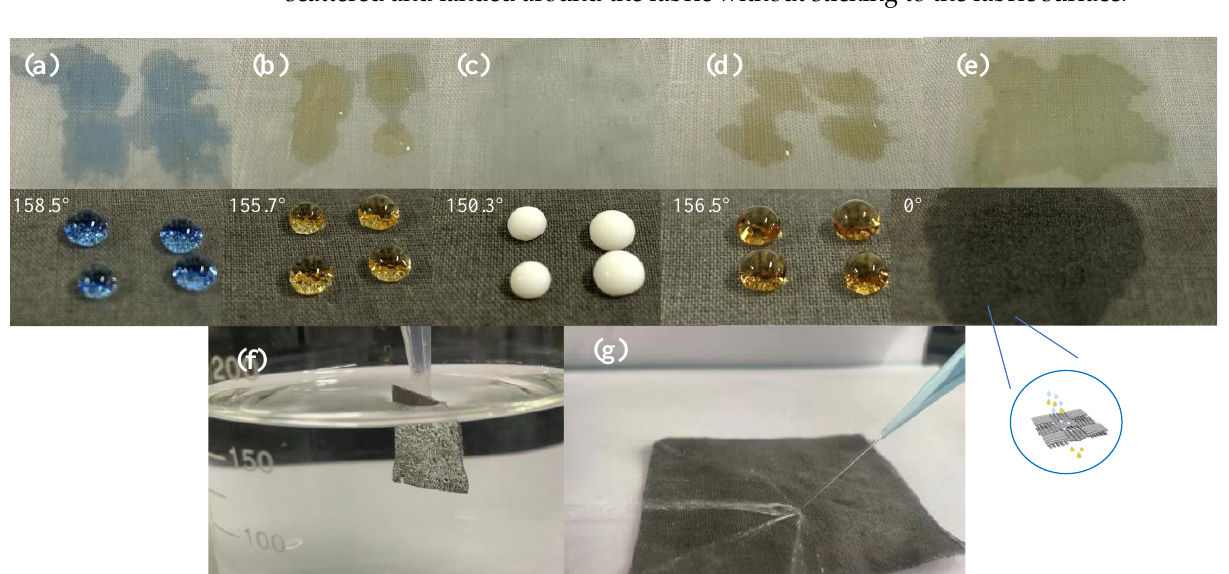
Figure 7. Droplets of Everacid Blue N-RL dyed water ( a ) cola ( b ), milk ( c ), tea ( d ), and vegetable oil ( e ) on the surface of original PET (upper) and CA-Fe-SH-PET (under); state of CA-Fe-SH-PET fabric in water ( f ); state of water spray on CA-Fe-SH-PET fabric ( g ). Self-cleaning is the most prominent feature of superhydrophobic surfaces. As shown in Figure 8a–c, when the pollutants (Bengal rose dye) on the original PET fabric surface were washed by water drops, the PET surface directly adsorbed the water-soluble pollutants and was polluted. The water droplets of pollutants had an ultra-low adsorption performance on the superhydrophobic surface. After washing with clean water, the water droplets could directly remove the pollutants and make them quickly leave the fabric surface, so that the fabric surface can be clean without leaving traces.